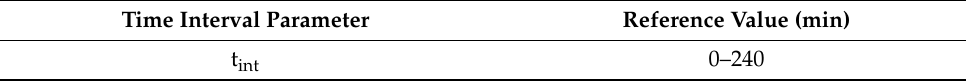
Table 6. Reference t int parameter for HT in combination with RT or